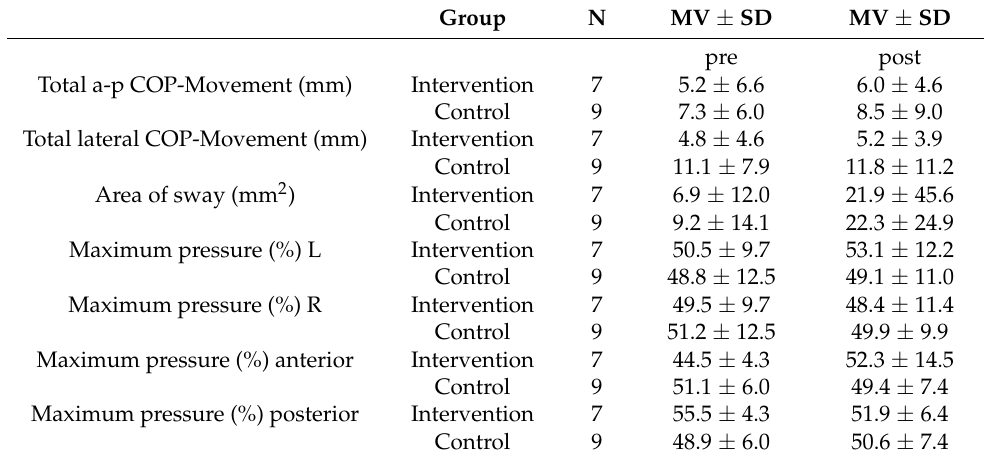
Figure 6. Changes in pedobarography results. Delta from T1 to T2. Pressure distribution (green arrows); anterior-posterior and lateral body center of gravity fluctuation (black arrows); area sway of body center of pressure (blue area); n = 16. Table 6. Results of the pedobarography measurements pre and post intervention.